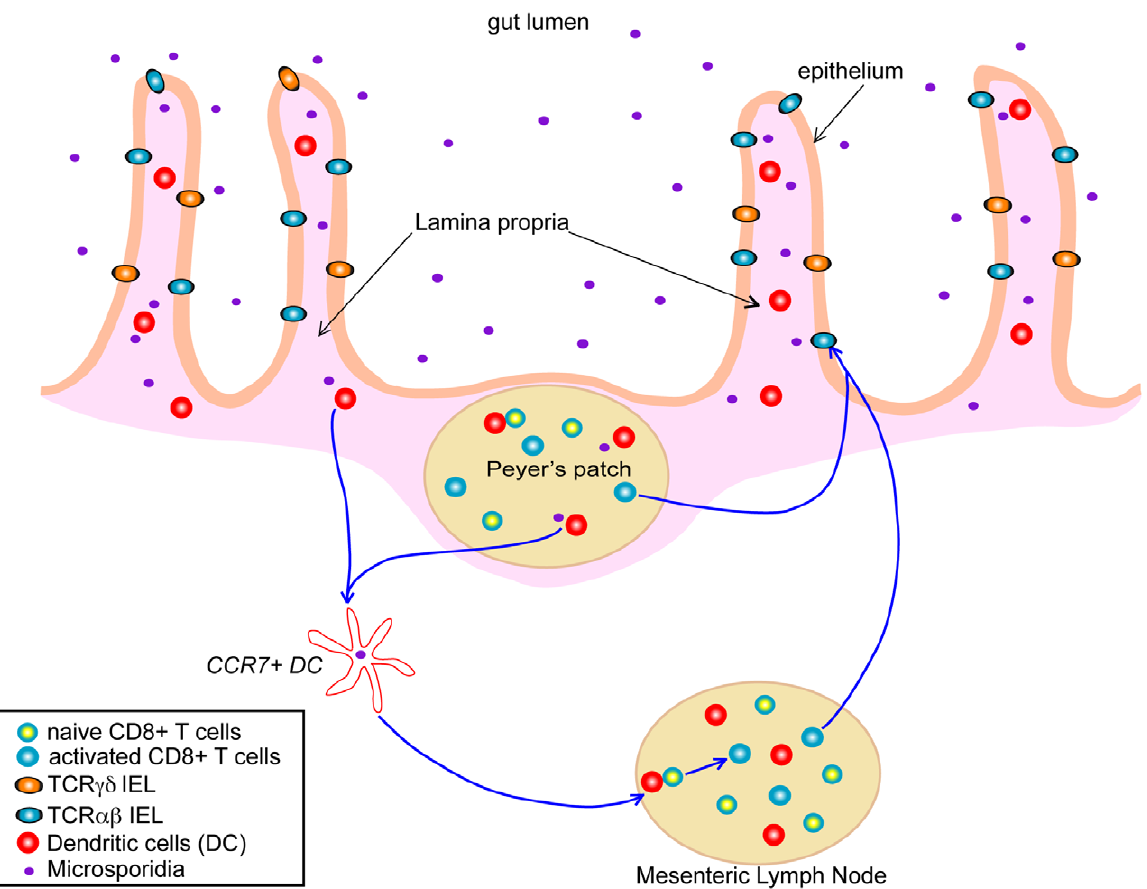
Figure 1. Putative model of the development of antigen-specific IEL response in the gut after infection with microsporidia. Once the infecting microsporidia cross the gut intestinal barrier, they are picked up by dendritic cells (DC) either in the Peyer’s patch or the lamina propria. These DC become activated, express CCR7, and then migrate to the Mesenteric Lymph Nodes (MLN), where they encounter naı¨ve CD8 + T cells. After antigen presentation, these CD8 + T cells become activated and now express different homing and chemokine receptors that allow them to traffic back to the gut mucosa, where they disseminate throughout the intestinal epithelium, becoming TCR ab IEL and TCR cd IEL.